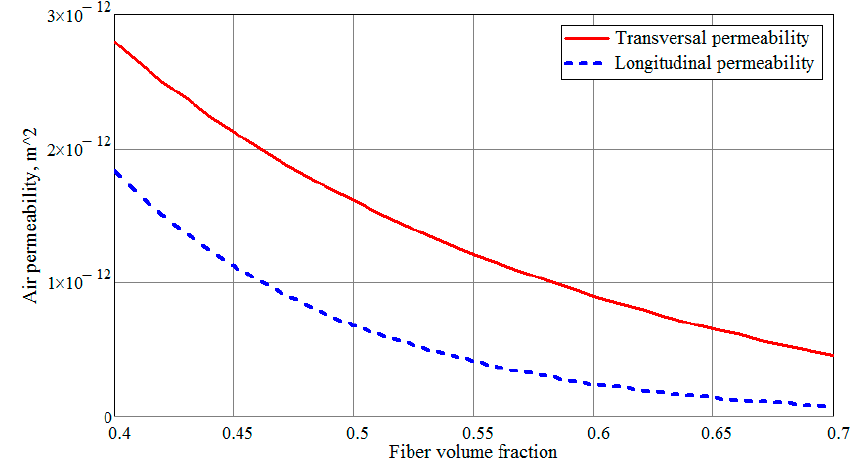
Figure 11. The dependencies of the air permeability along and transverse CFRP fabric with hexagonal woven arrangement (calculated according to Equation (16)).